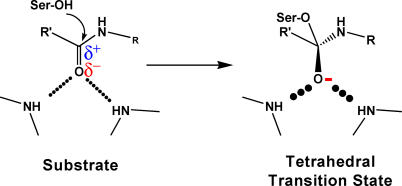
The Serine Protease Reaction Showing Interactions in the Oxyanion Hole